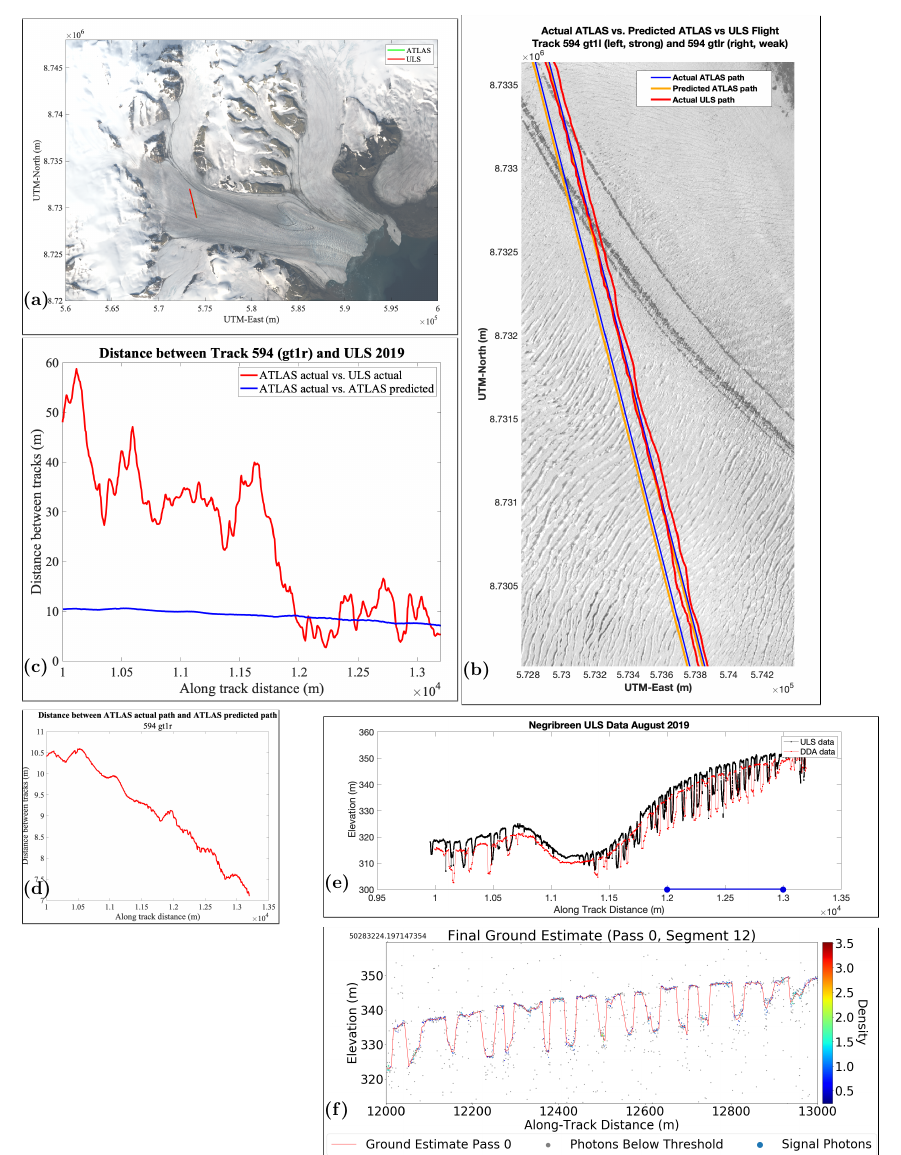
Figure 14. ICESat-2 ATLAS vs. ULS data. Track repeat accuracy and results. RGT 594, gt1r (weak), overpass 2 (high winds of 60 km/h). Negribreen validation campaign. Flight 2, 13 August 2019. ( a ) Location of DDA segments over Negribreen and closest ULS data (note the tracks are so close that the green line disappears under the red line). For segment numbering, see Figure 9 (ATLAS DDA segments). Background: Landsat-8 image from 5 August 2019 [LC08_L1TP_215003_20190805_20190820_01_T1]. Segment lengths in ( a , c – e ) are the same, segments in ( b , f ) are subsets. ( b ) Track separation between our ULS flight path, the ATLAS predicted flight path, and the ATLAS actual flight path for granule: